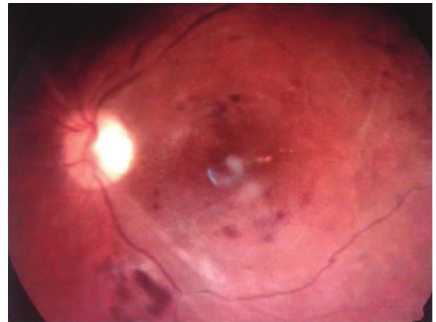
Figure 8: Macular edema